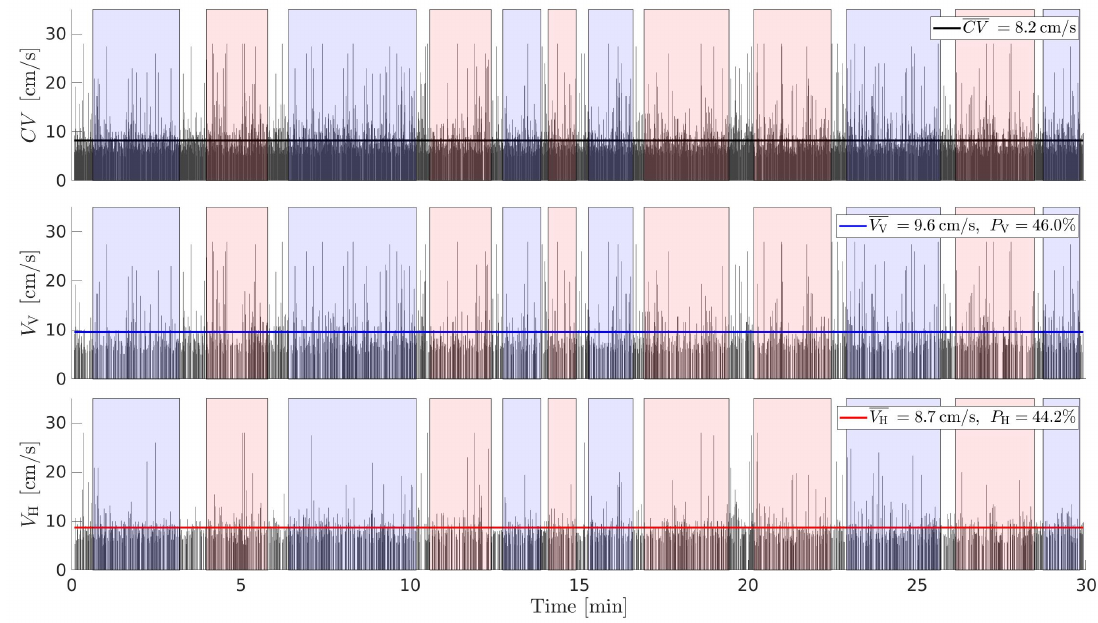
Figure A4. Conduction velocity amplitudes, CV , and conduction velocity amplitudes in the vertical, V V , and horizontal, V H , directions of the record tpehgt_t009 in the frequency band B1. CV —the average conduction velocity. V V , V H —the average conduction velocities ( CV (cid:54) = 0) in the vertical and horizontal directions. P V , P H —the percentages of conduction velocities in the vertical and horizontal directions. Blue: dummy intervals, red: contraction